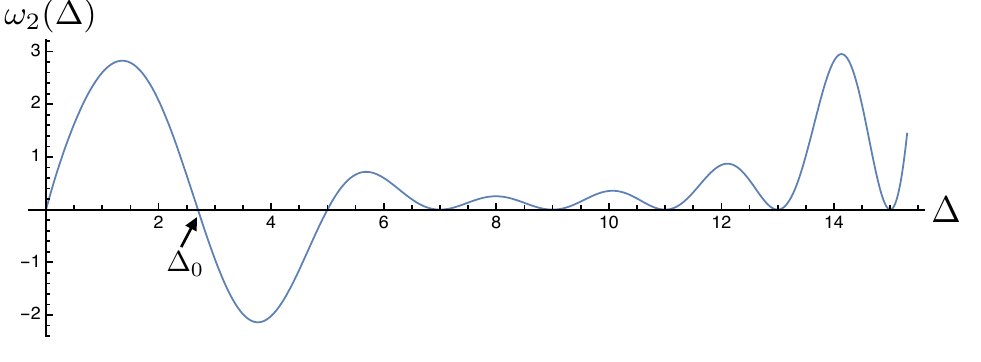
Figure 9 . The action of the extremal functional for (cid:1) = 2, given by equation (5.16). The location (cid:1) 0 of the only zero in 0 < (cid:1) < 2(cid:1) + 1 will satisfy as (cid:1) 0 = (cid:1) cancelled by double poles of (cid:10) (cid:1) ((cid:1)). The only zero of ! (cid:1) ((cid:1)) in this region occurs